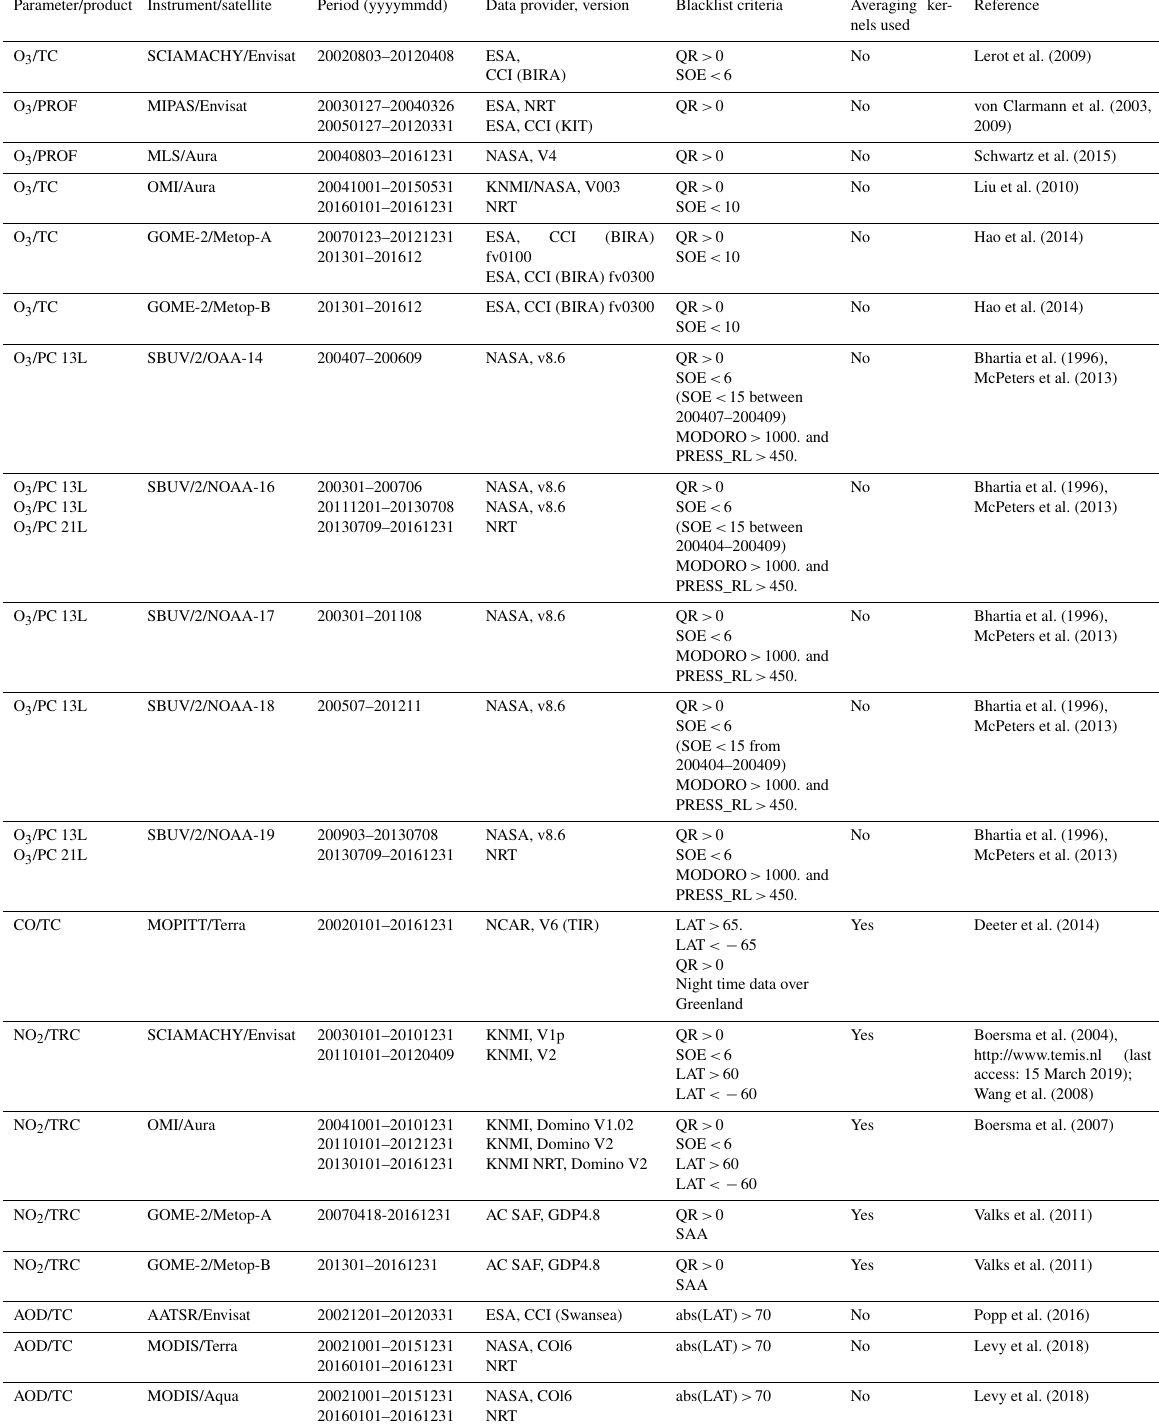
Table 2. Satellite retrievals of atmospheric composition that were assimilated in the CAMS reanalysis. TC is total column, TRC is tropo- spheric column, PROF is profiles, PC is partial columns, QR is quality flag given by data providers, SOE is solar elevation, MODORO is model orography, PRESS_RL is pressure at bottom of layer, LAT is latitude and SAA is area of the South Atlantic Anomaly. Parameter/product